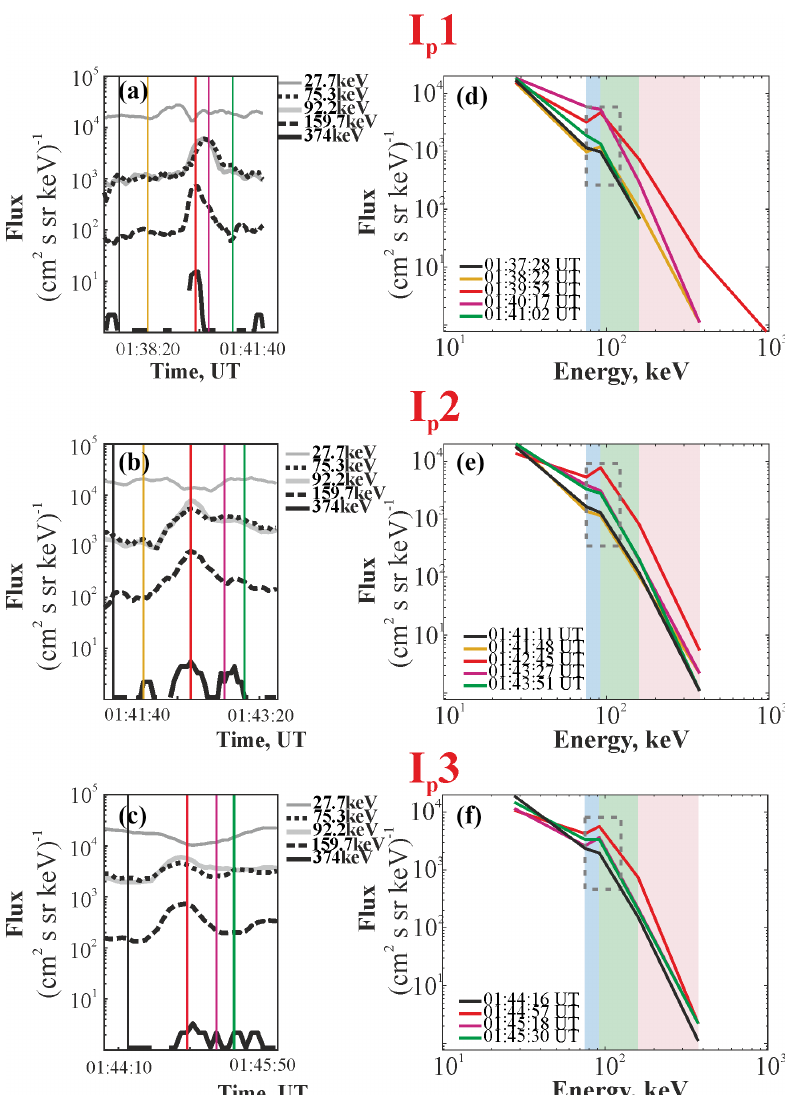
Figure 6. The observations of proton fluxes and spectra by the C4 spacecraft. The format is similar to the format of Fig. 4 except for wave